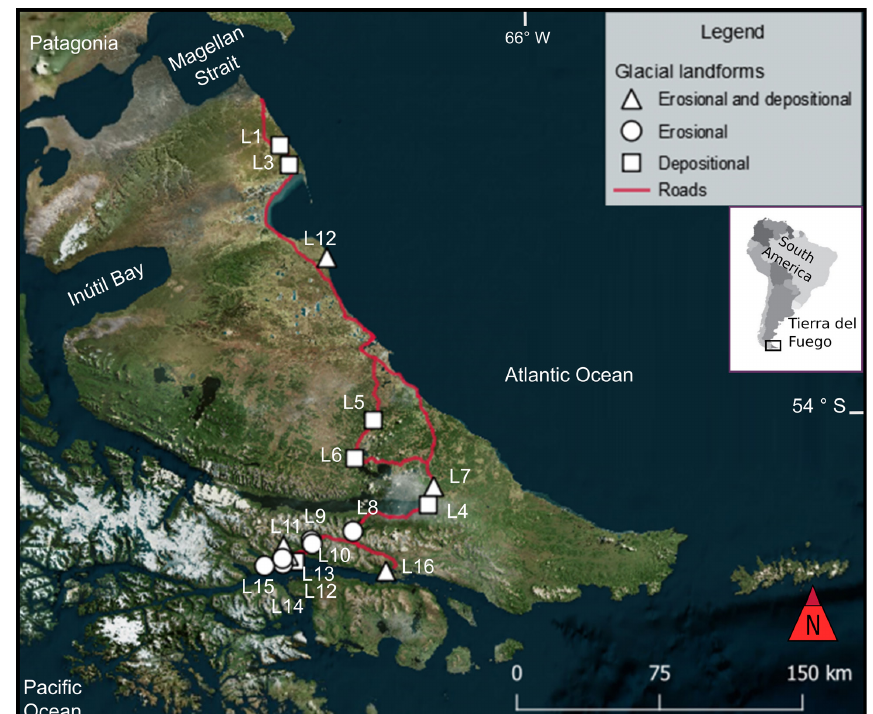
Fig. 3. Location of the 16 glacial landforms herein